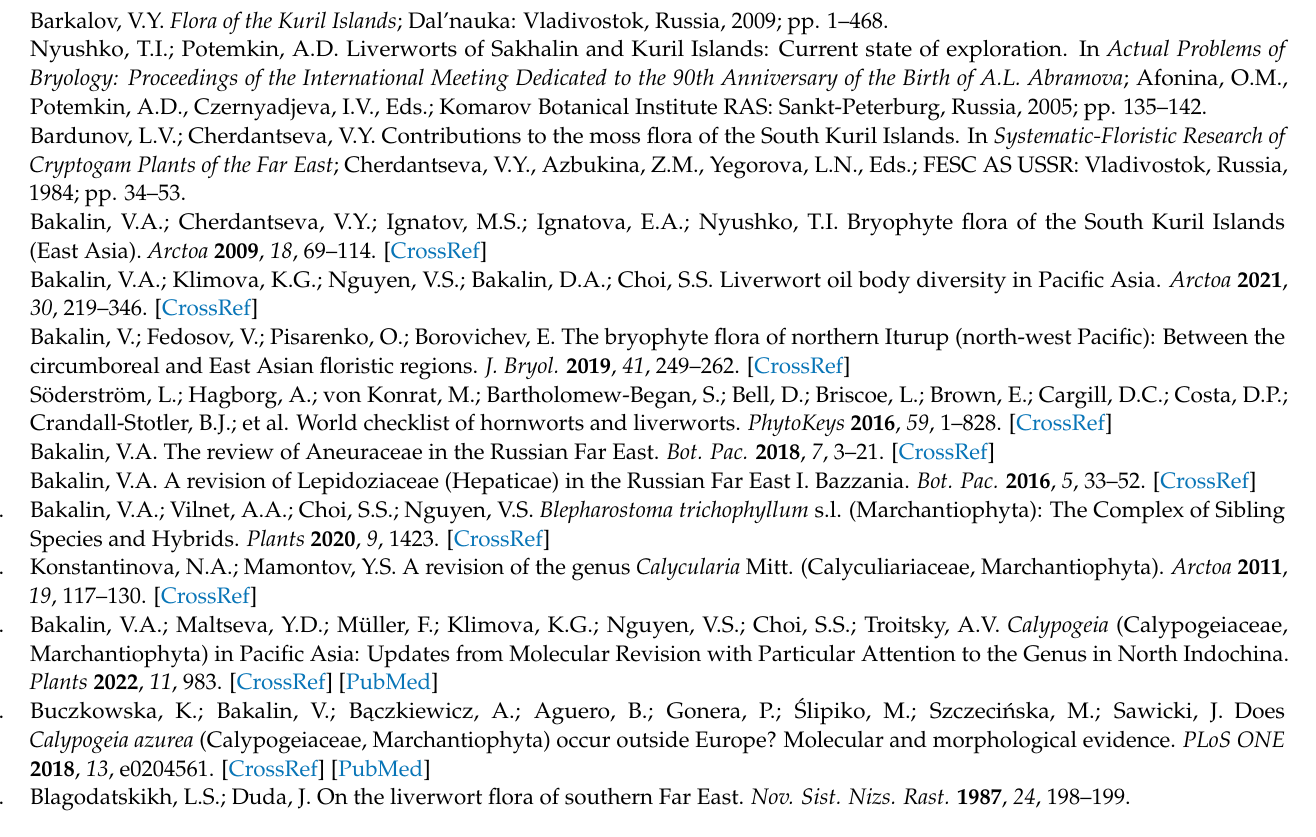
Table S1: Bioclimatic data involved into